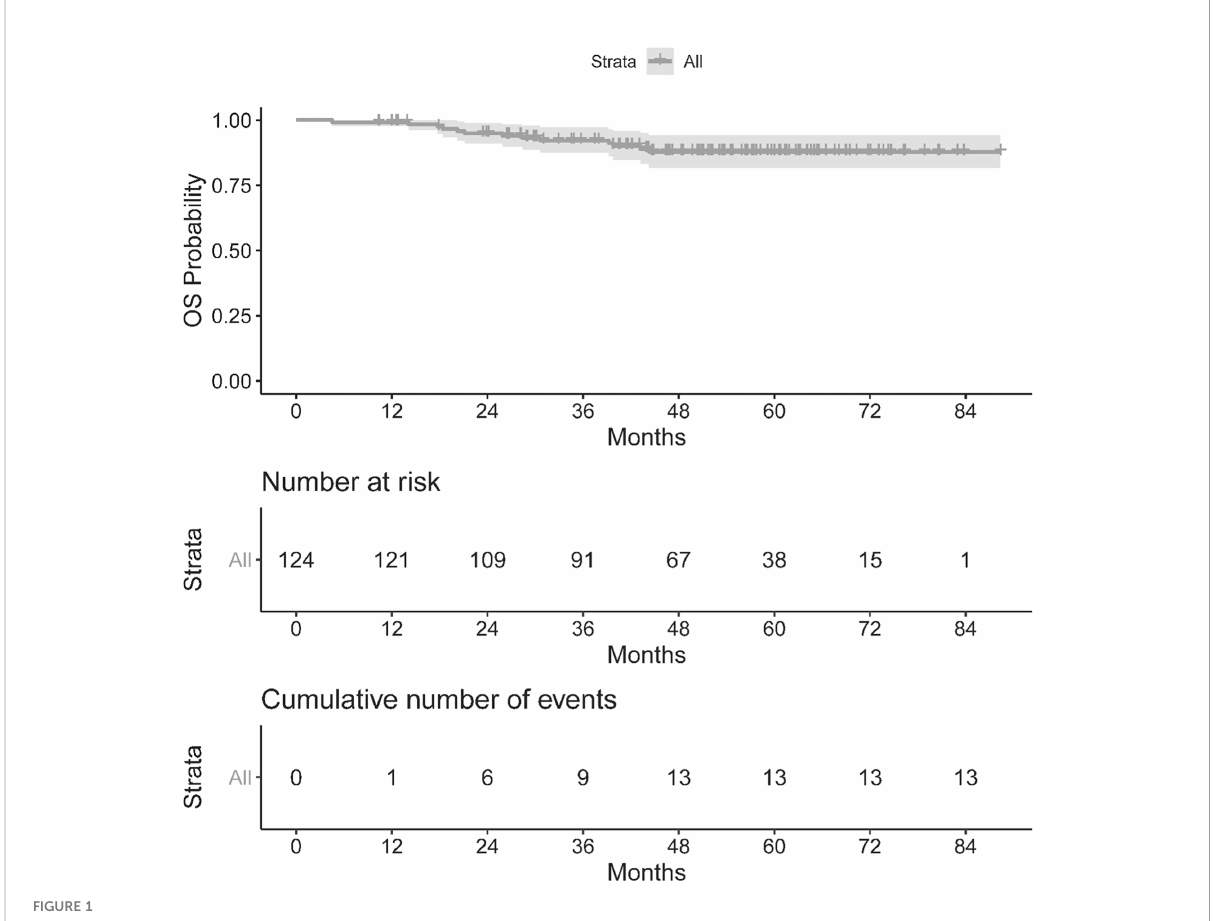
FIGURE 1 Kaplan – Meier curve for Overall